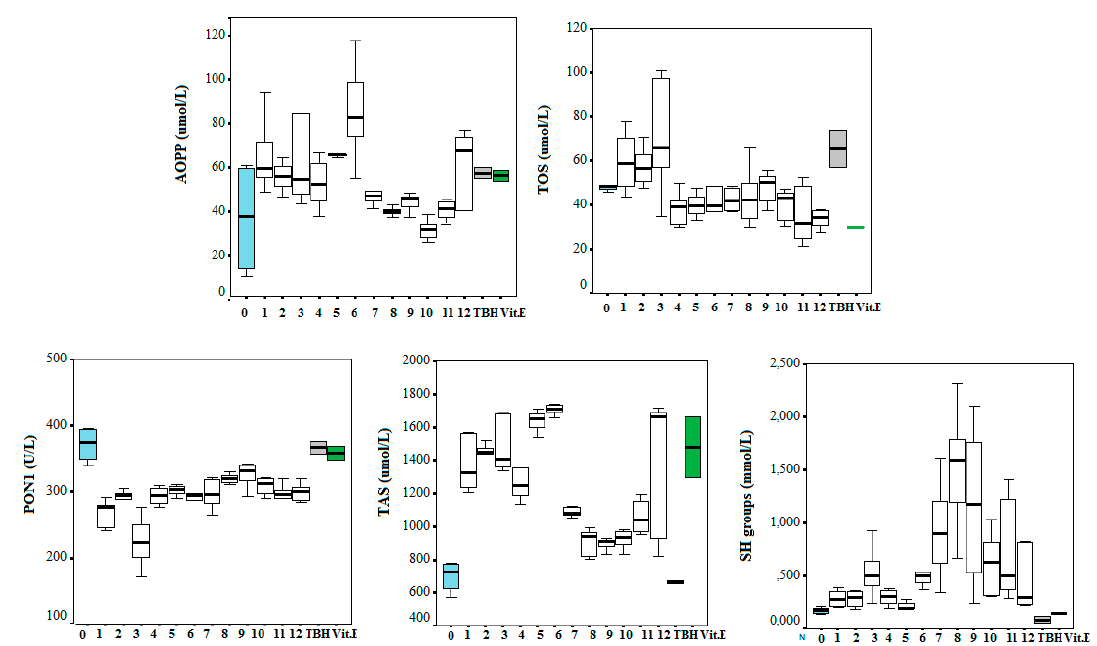
Figure 1. Oxidative stress status parameters after the addition of the tested compounds numbered from 1–12. Blank serum pool is signed as 0 (blue box); TBH—serum pool with prooxidant substance terc-buthyl-hydroperoxide (grey box) and serum pool with vitamin E as antioxidative substance (green box).